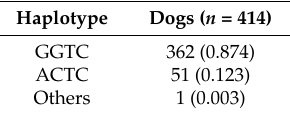
Table 3. Haplotype frequency of four PRND polymorphisms in dogs.